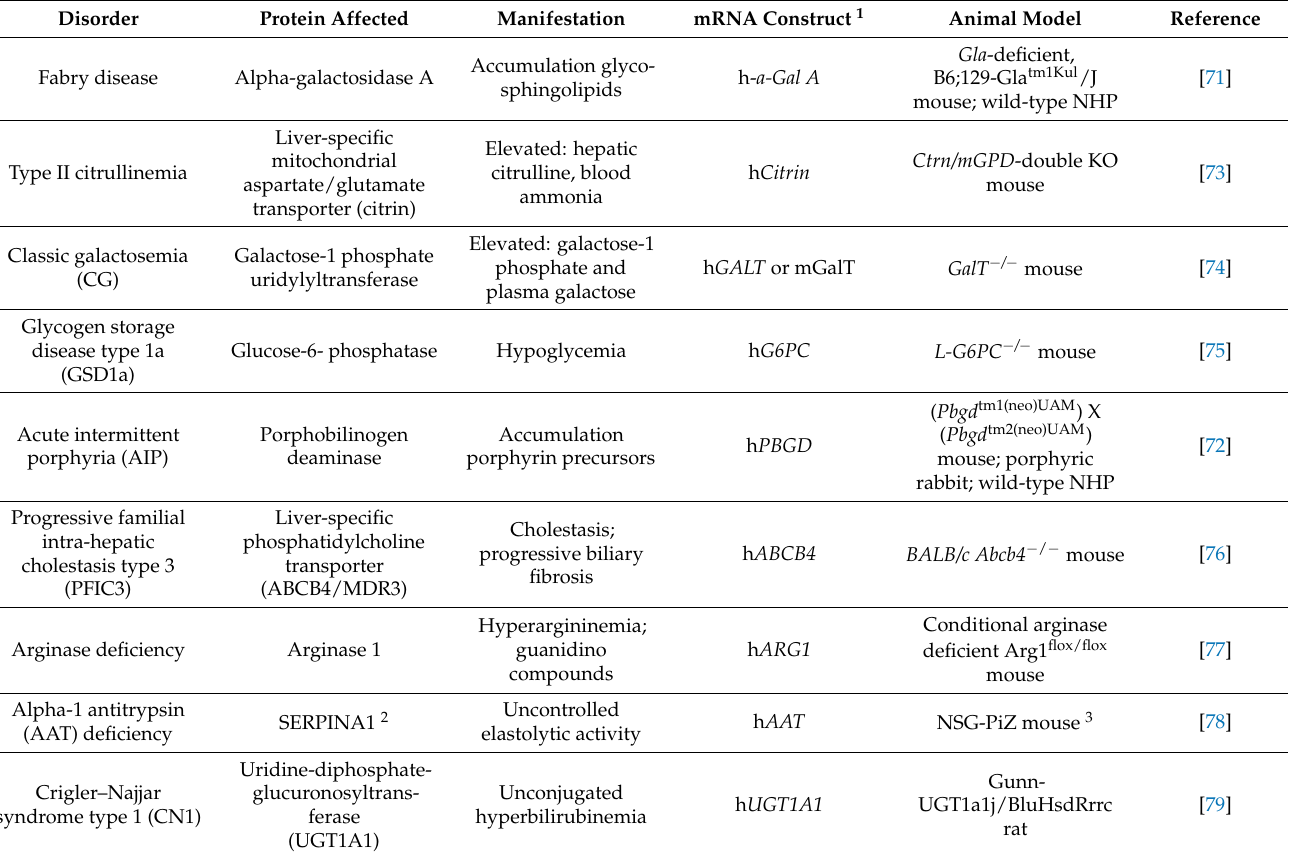
Table 1. Preclinical studies using LNP-encapsulated mRNA constructs to treat rare inherited metabolic liver